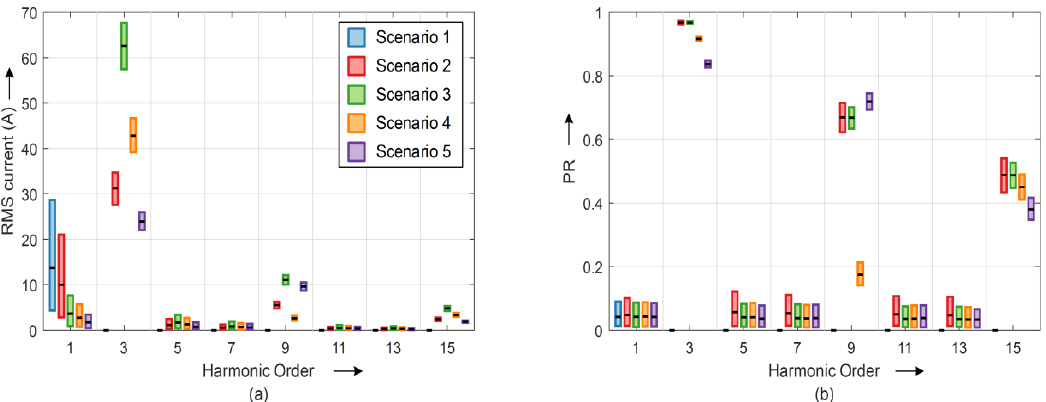
Figure 6. Overview of the neutral currents under sinusoidal supply voltage at analysis point 1: ( a ) harmonic components; ( b ) prevailing ratios.